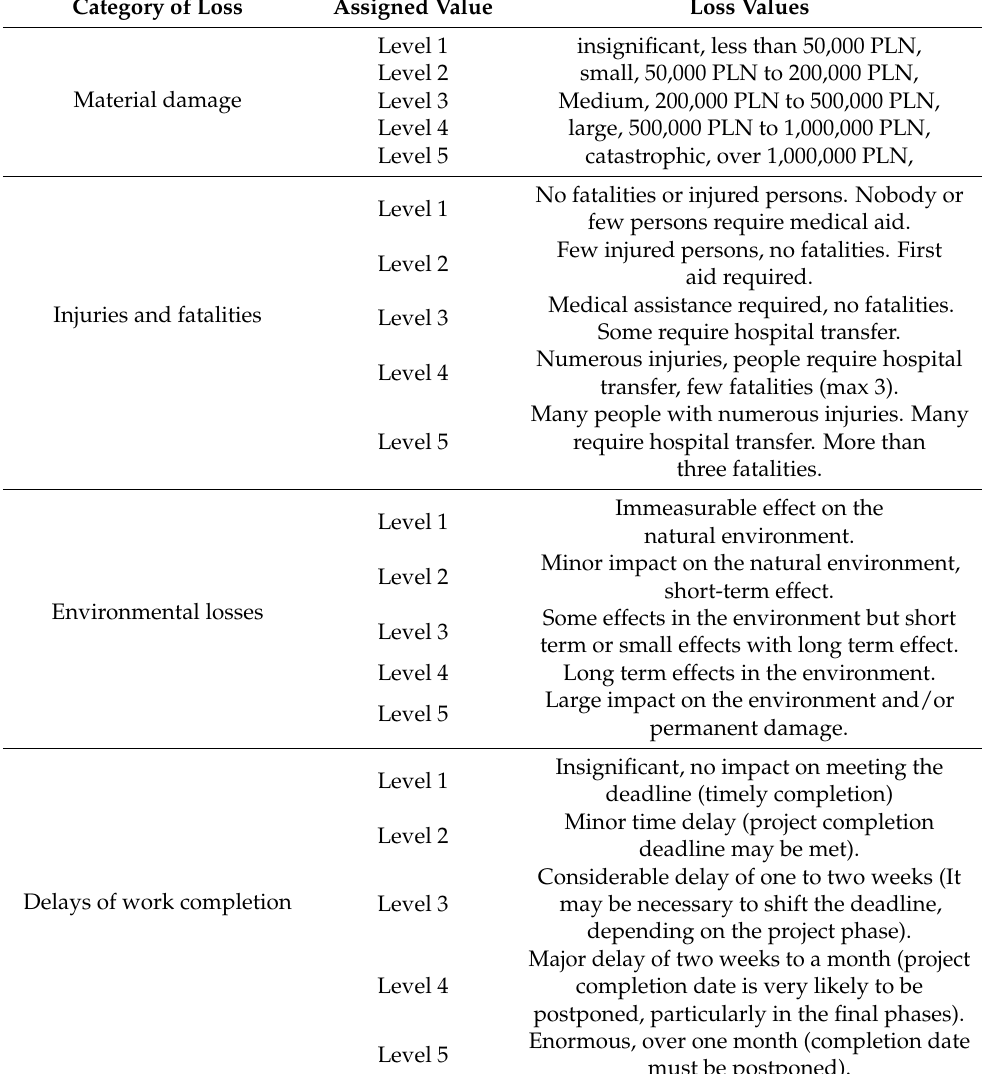
Table 7. Estimation of losses associated with threats in the investment